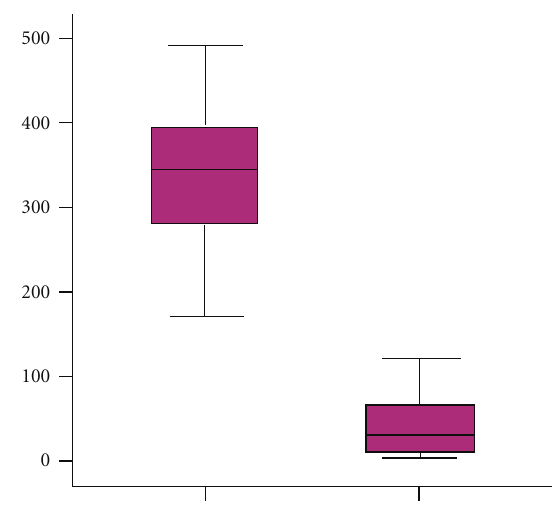
Figure 1: Serum IL-18 concentration was significantly elevated in patients with IgAN than healthy controls ( P < 0 .